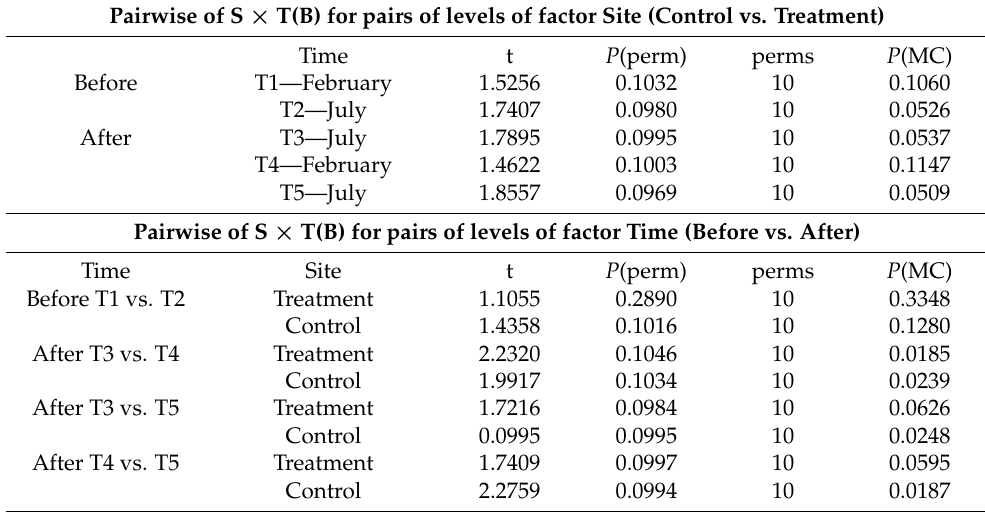
Table 4. Pairwise PERMANOVA on benthic assemblages of Treatment and Control sites at Before (T1, T2) and three After (T3–T5) the bioremediating action. Pairwise of S × T(B) for pairs of levels of factor Site (Control vs. Treatment) Time t P (perm) perms P (MC) Before T1—February 1.5256 0.1032 10 0.1060 T2—July After T3—July 1.7895 T4—February Pairwise of S × T(B) for pairs of levels of factor Time (Before vs. After) Time Site t P (perm) perms P (MC) Before T1 vs. T2 Treatment 1.1055 0.2890 Control After T3 vs. T4 Treatment 2.2320 After T3 vs. T5 Treatment 1.7216 After T4 vs. T5 Treatment